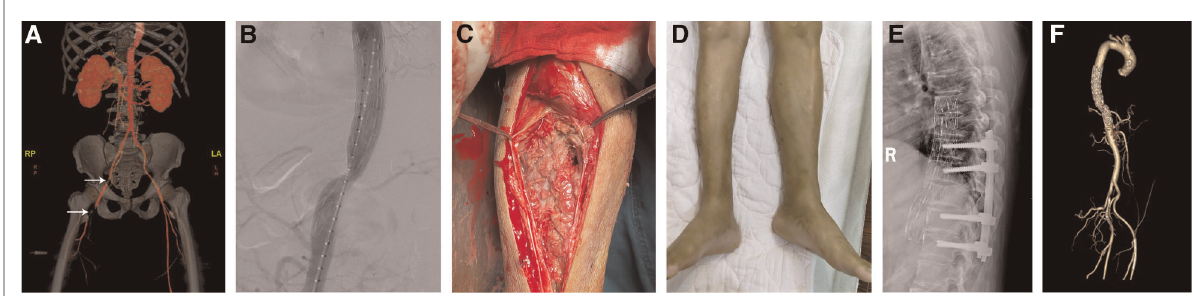
FIGURE 2 Filling defect at the right external iliac artery and femoral artery bifurcation with severe luminal stenosis (white arrows) ( A ). Angiogram obtained on completion of the procedure showing adequate placement of the stent graft with no endoleak or kink ( B ). Thirteen days after the right lower leg fasciotomy, there was still extensive necrosis in the posterior leg muscles ( C ). The circumference of the right calf was smaller than that of the left calf at 7 months after fl ap reconstruction surgery ( D ). A lateral radiograph obtained after 1 year of follow-up shows the aortic stent graft in situ and stabilization of the vertebral fracture at T10 ( E ). A repeated CTA performed 1 year of follow-up showed the stent without endoleak ( F